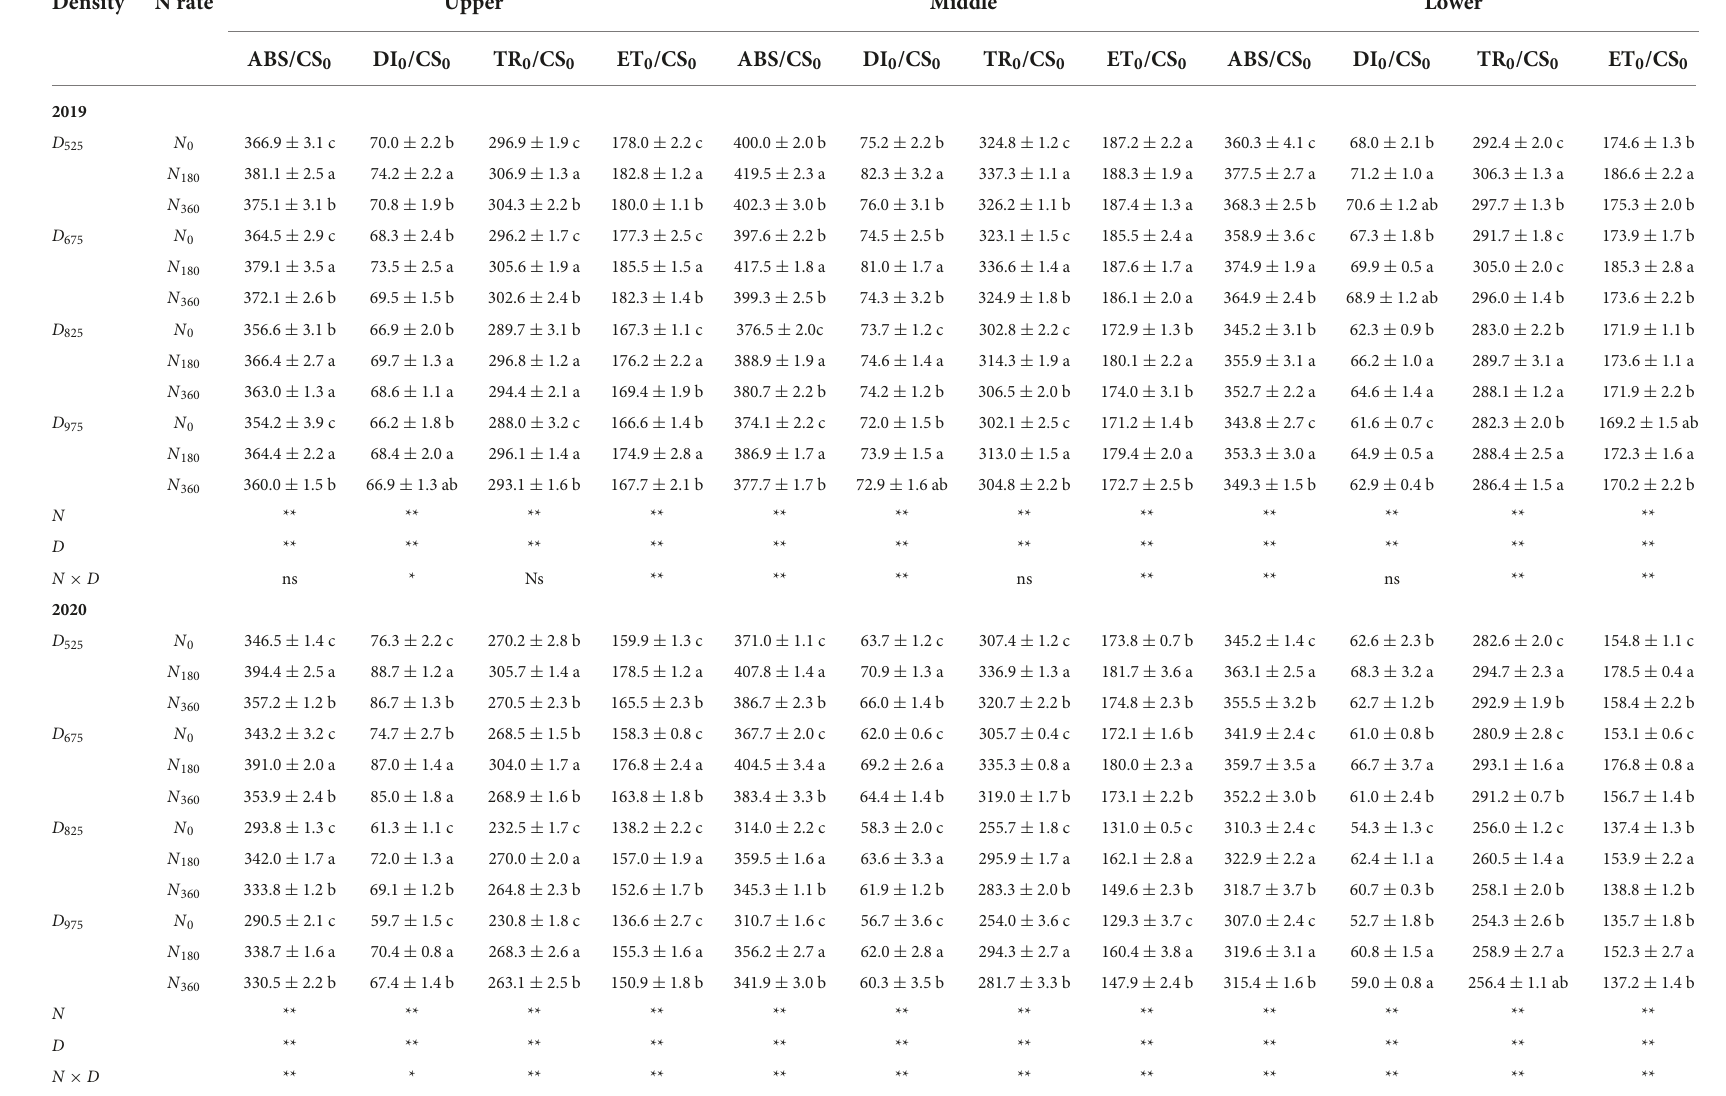
TABLE 2 Influence of N rate and plant density on the leaf specific energy fluxes per cross section (CS) at different leaf positions. Density N